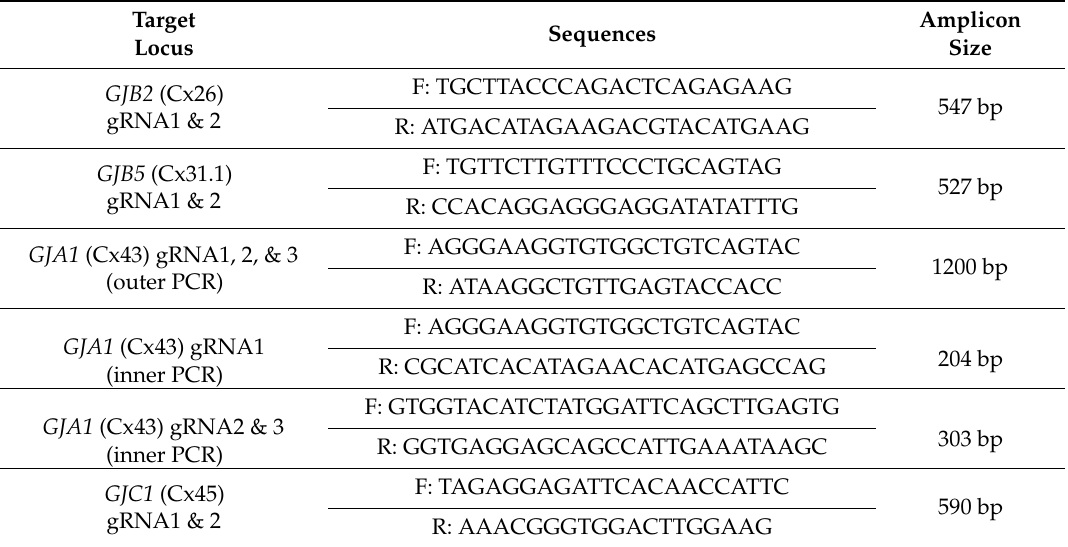
Table 3. PCR primers for T7E1